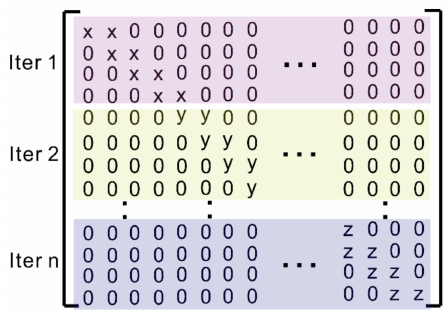
Figure 5. Schematic of the time-based reconstruction